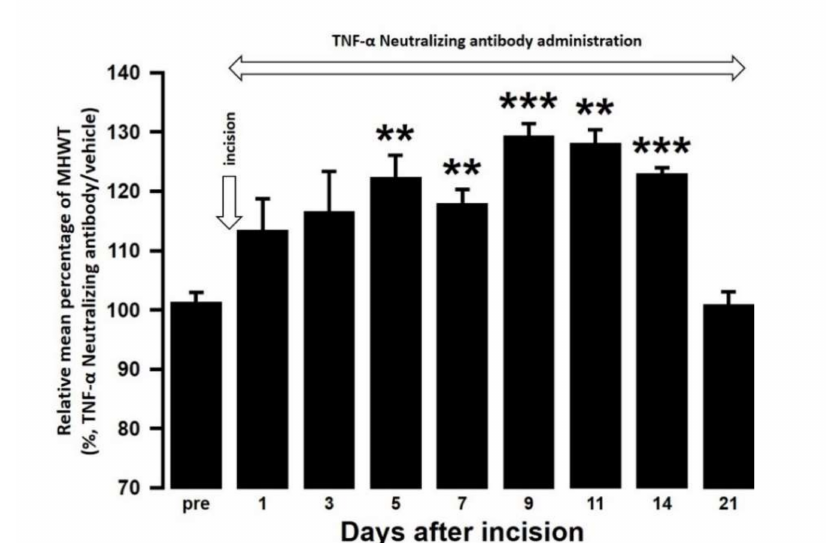
Figure 7. Changes in MHWT in SAMP8 mice treated with either a TNF- α neutralizing antibody or vehicle following palatal mucosal incision. The relative mean percentage MHWT was calculated